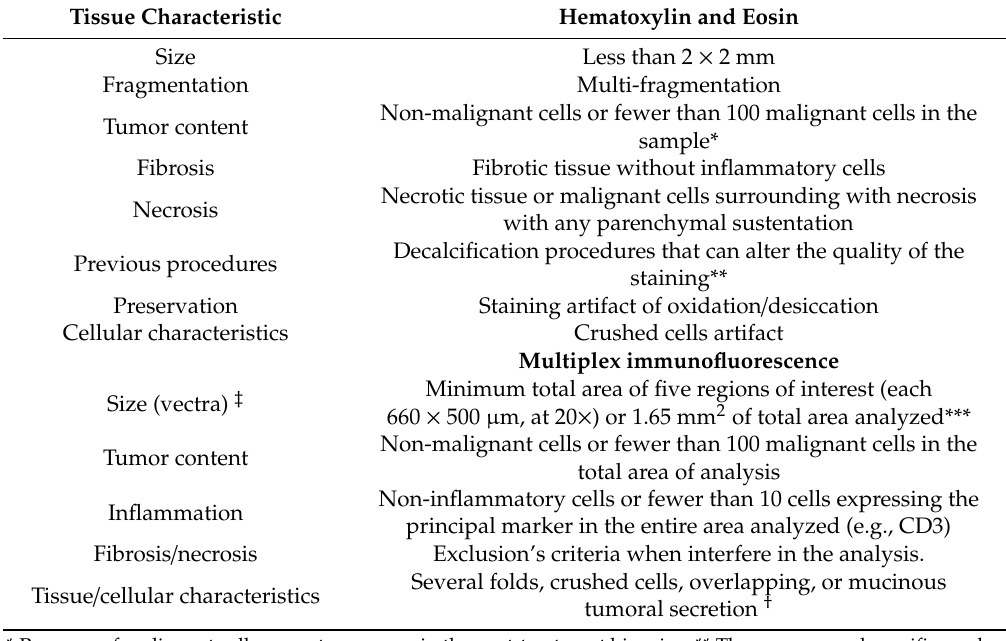
Table 2. Recommended baseline sample exclusion criteria for longitudinal